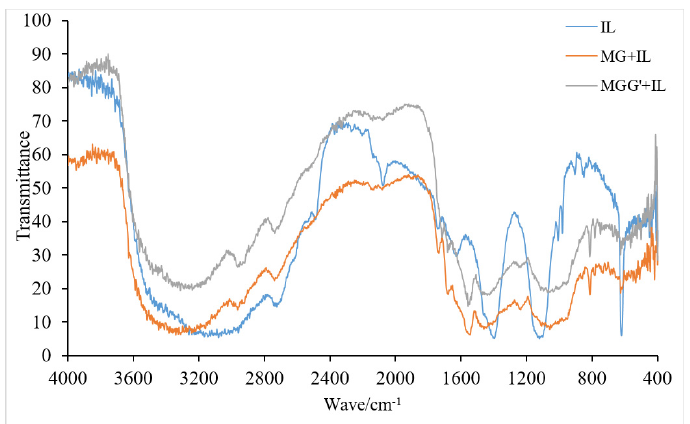
Figure 7. FT-IR spectra of hardened MG and MGG’ resins.